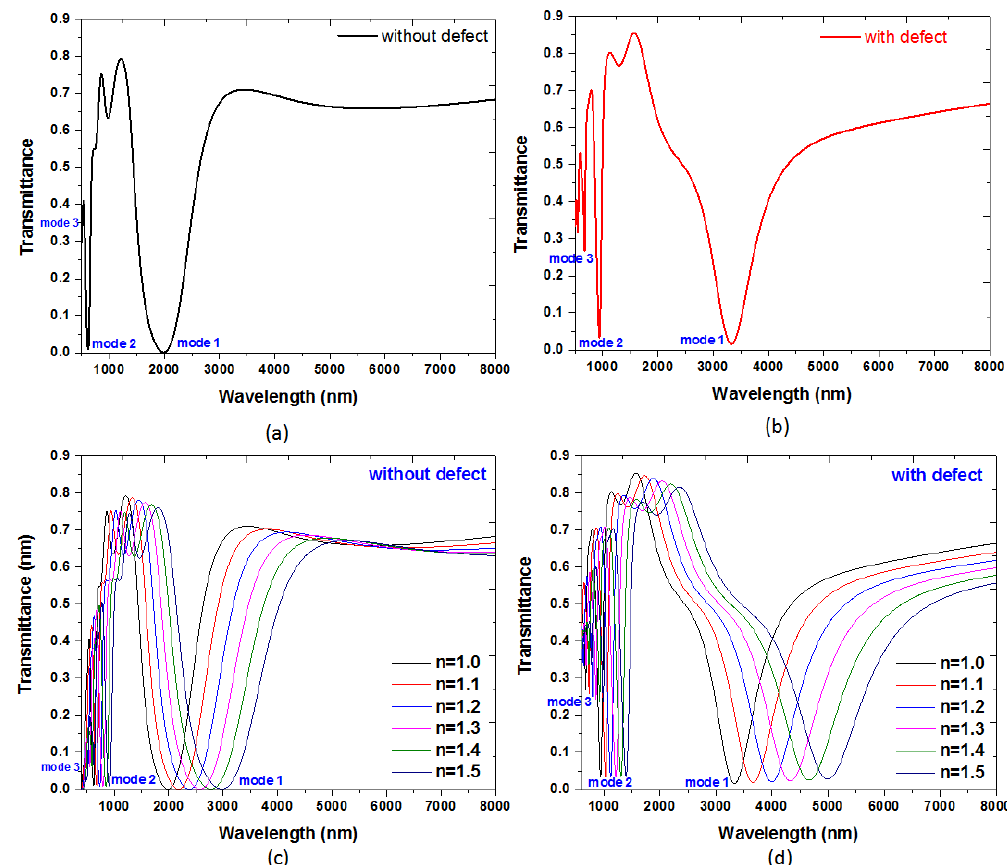
Figure 2. Transmittance spectrum of the proposed plasmonic MIM waveguide ( a ) without defects and ( b ) with silver nanorod defects. Transmittance spectra of the proposed MIM sensor ( c ) without and ( d ) with the silver nanorod defects in the T-shape cavity filled with different refractive index (RI) ( n = 1.00, 1.10, 1.20, 1.30, 1.40 and 1.50) in the active region of the sensor. The structural parameters of the proposed MIM waveguide, w , w 1 , w 2 , d 1 , d 2 , r 1 , r 2 , are set to be 50 nm, 50 nm, 30 nm, 150 nm, 330 nm, 20 nm and 10 nm, respectively.